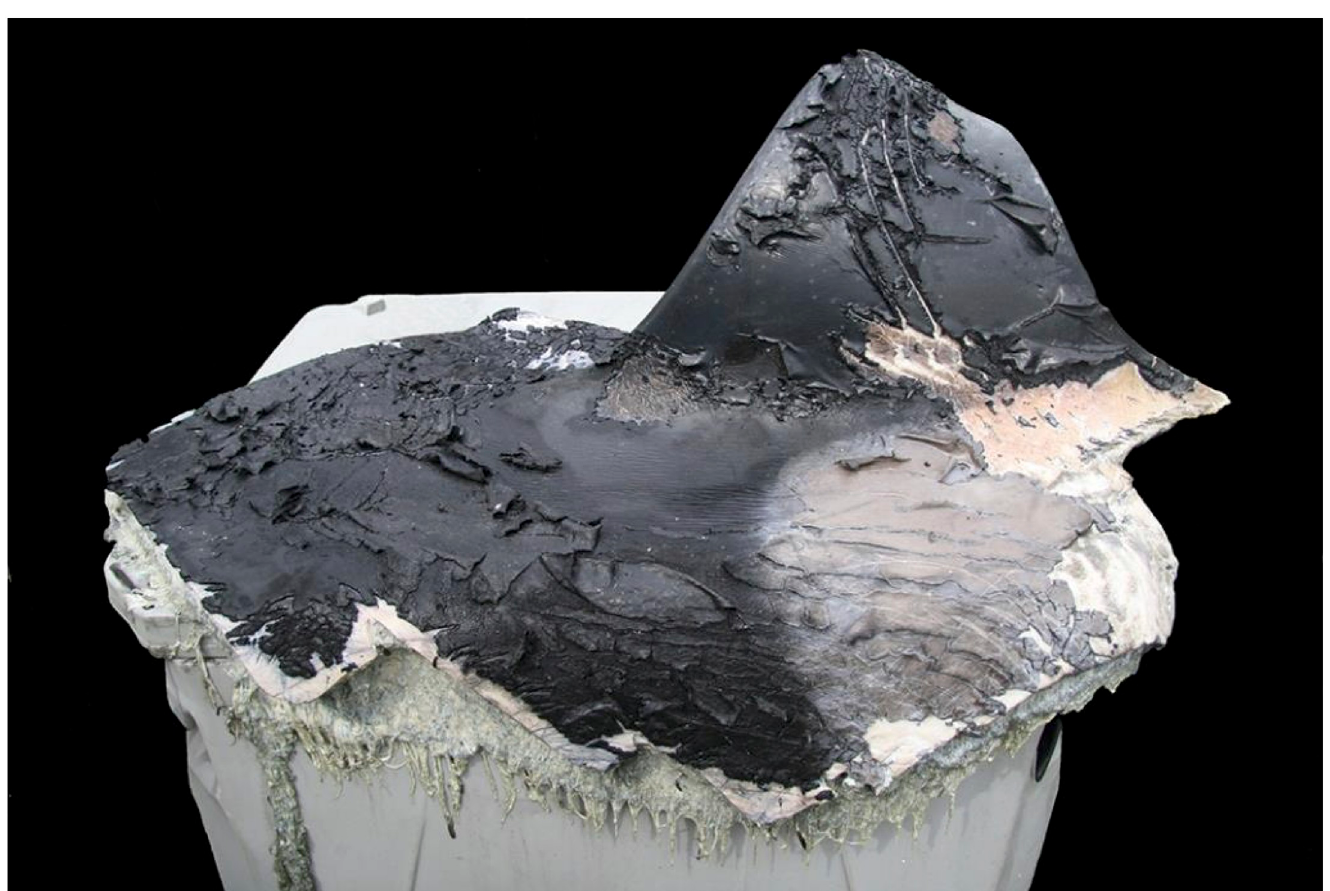
Fig 6. Skin, blubber and muscle of a transient (ID# T086) that died from a vessel strike.